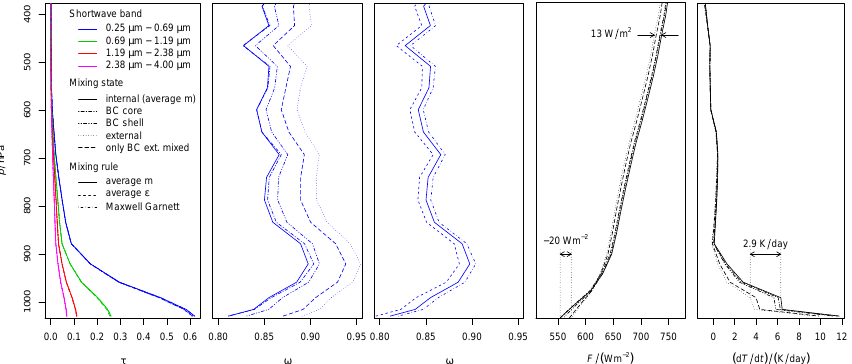
Figure 8. Column model results over China. From left to right: aerosol optical depth τ , single-scattering albedo ω , single-scattering albedo (alternative mixing rules), net shortwave flux F , temperature tendency d T/ d t . The optical depth is shown for each shortwave band, whereas the single-scattering albedo is shown only for the dominant band (0.25–0.69µm). The flux takes all solar bands into account; in addition, the temperature tendency takes the effects of terrestrial infrared radiation into